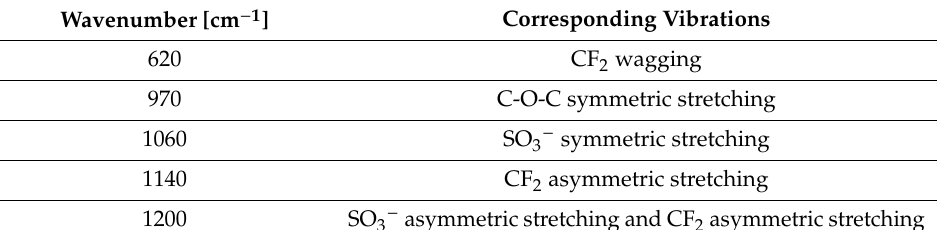
Figure 2. ( a ) Scanning electron microscopy (SEM) image of TiND | AuNP electrode, ( b ) Fourier-transform infrared spectroscopy (FT-IR) spectrum of TiND | AuNP electrode covered with Nafion. Table 1. Characteristic IR bands found for Nafion coating